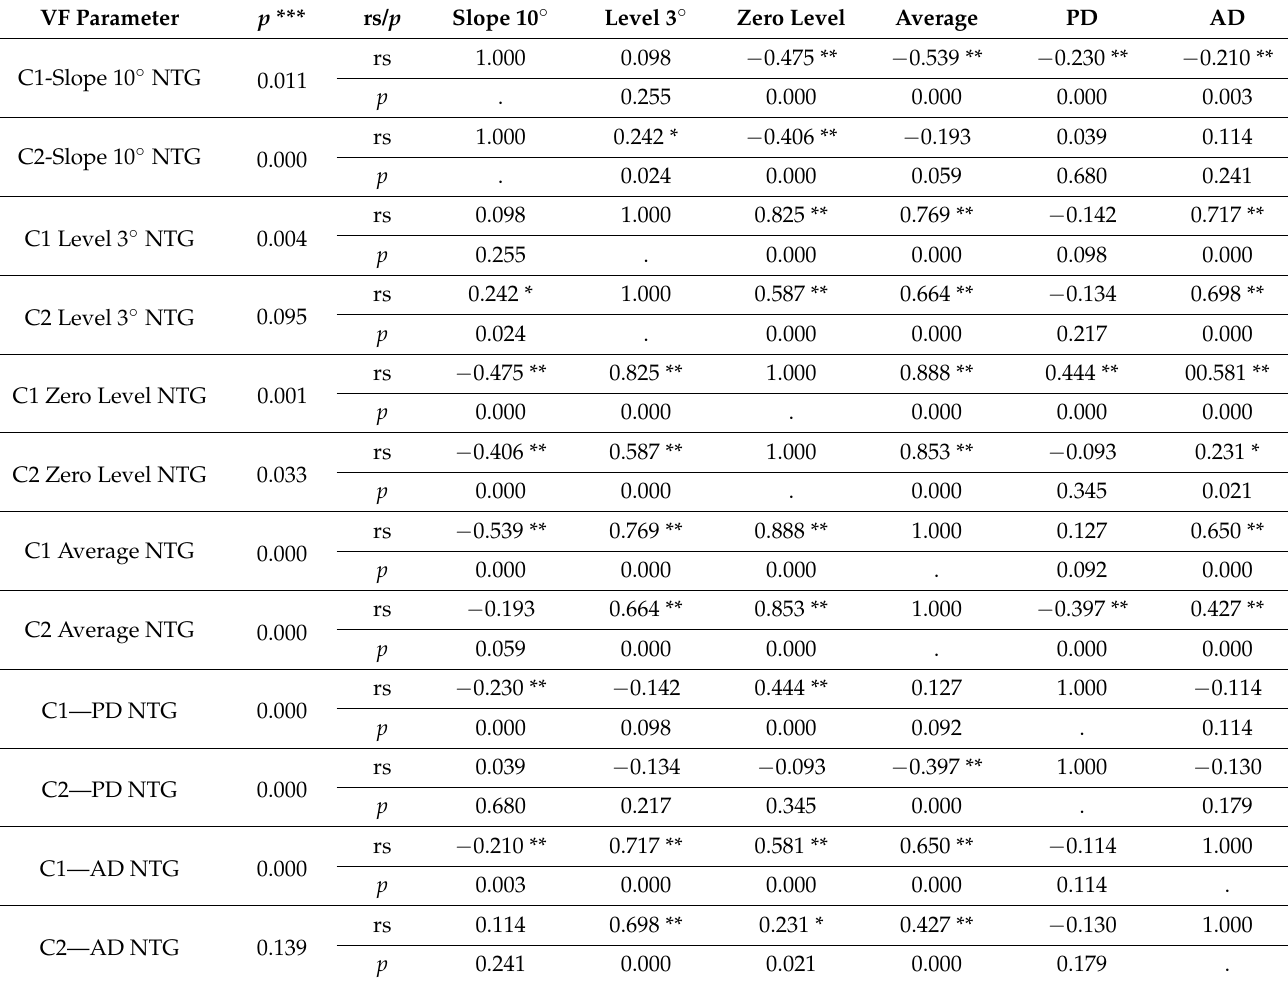
Table 10. Comparative distribution of “Visual field” parameters in patients with POAG at the first consultation (C1) and at the last consultation